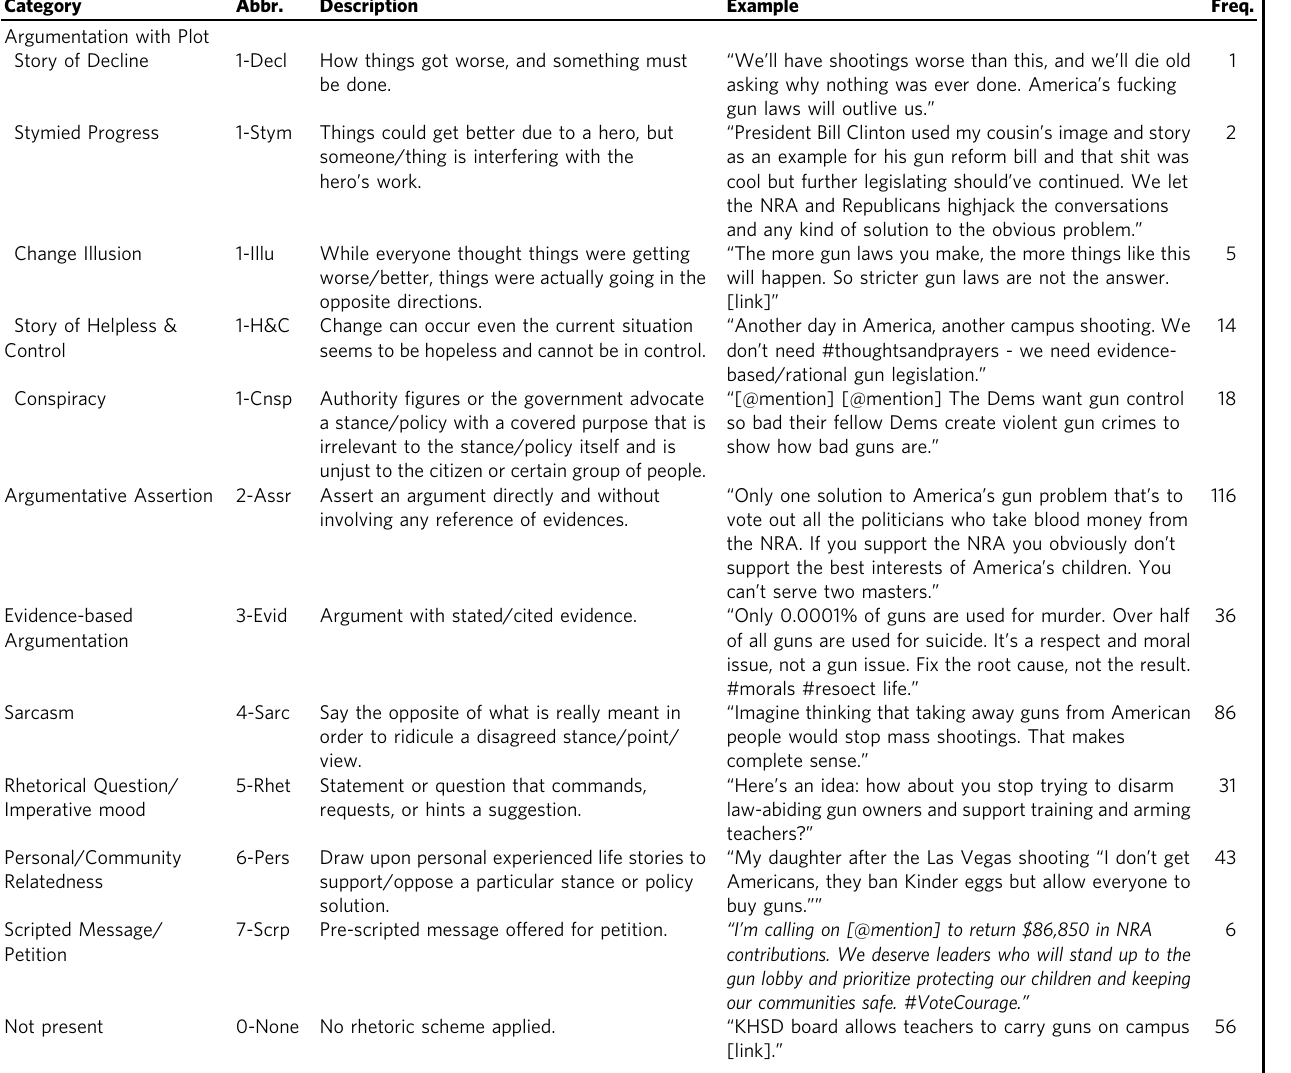
Table 4 Sub-category coding for Rhetoric Scheme